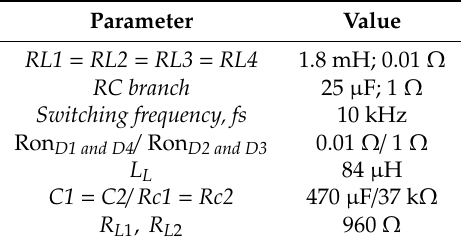
Table 4. Main parameters of VSI and Z NL